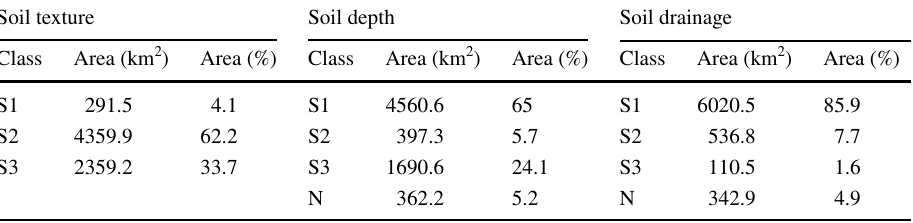
Table 10 Areal distribution of different soil property suitability